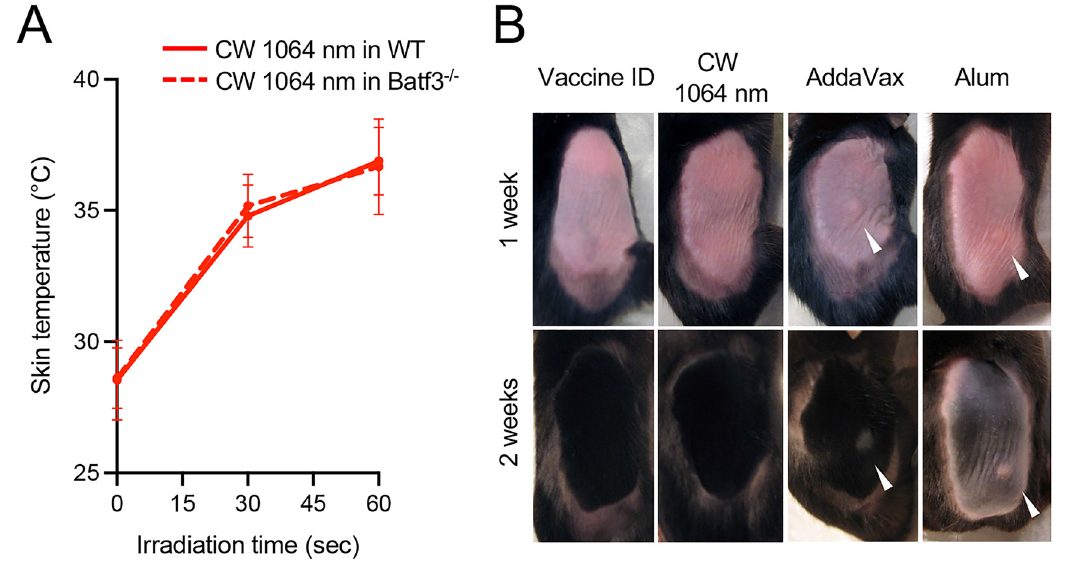
Figure 3: Effect of NIR laser and chemical adjuvants on skin tissue. (A)Dose – temperatureresponsesoftheCW1064nmlaserinmouseskin.Errorbarsshowmeans ± s.d. n =20,8forvaccineID + NIRlaserinWT and vaccine ID + NIR laser in Batf3 − / − groups, respectively. (B) Images of the back of mice for visual inspection at 1 and 2 weeks after the applicationofNIRlaserorchemicaladjuvant.WTandBatf3 − / − micewerevaccinatedIDwith1µgofinactivatedin fl uenzavirus(A/PR/8/34)with or without the NIR laser exposure or alum or AddaVax adjuvant. n = 6, 7, 3, 5 for vaccine ID only in WT, vaccine ID + NIR laser in WT, vaccine + Alum ID in WT, vaccine + AddaVax ID in WT groups, respectively. Representative images for each group are